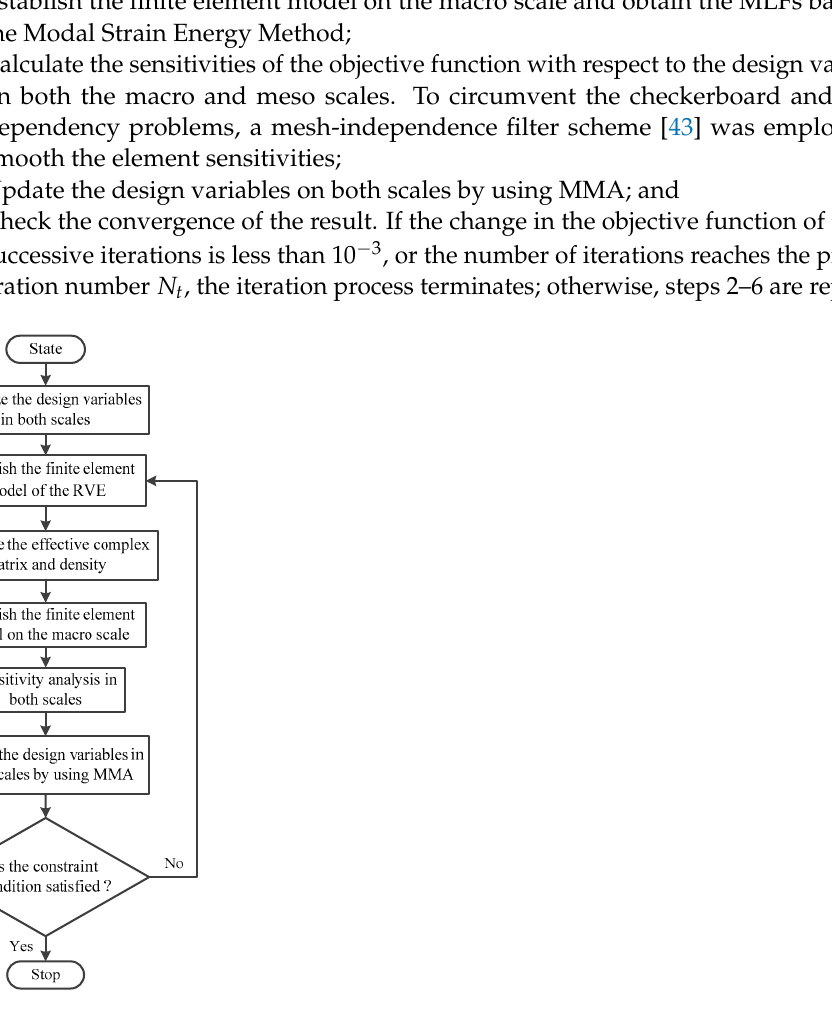
Figure 2. Flowchart of concurrent topology optimization for maximizing the modal loss factor.